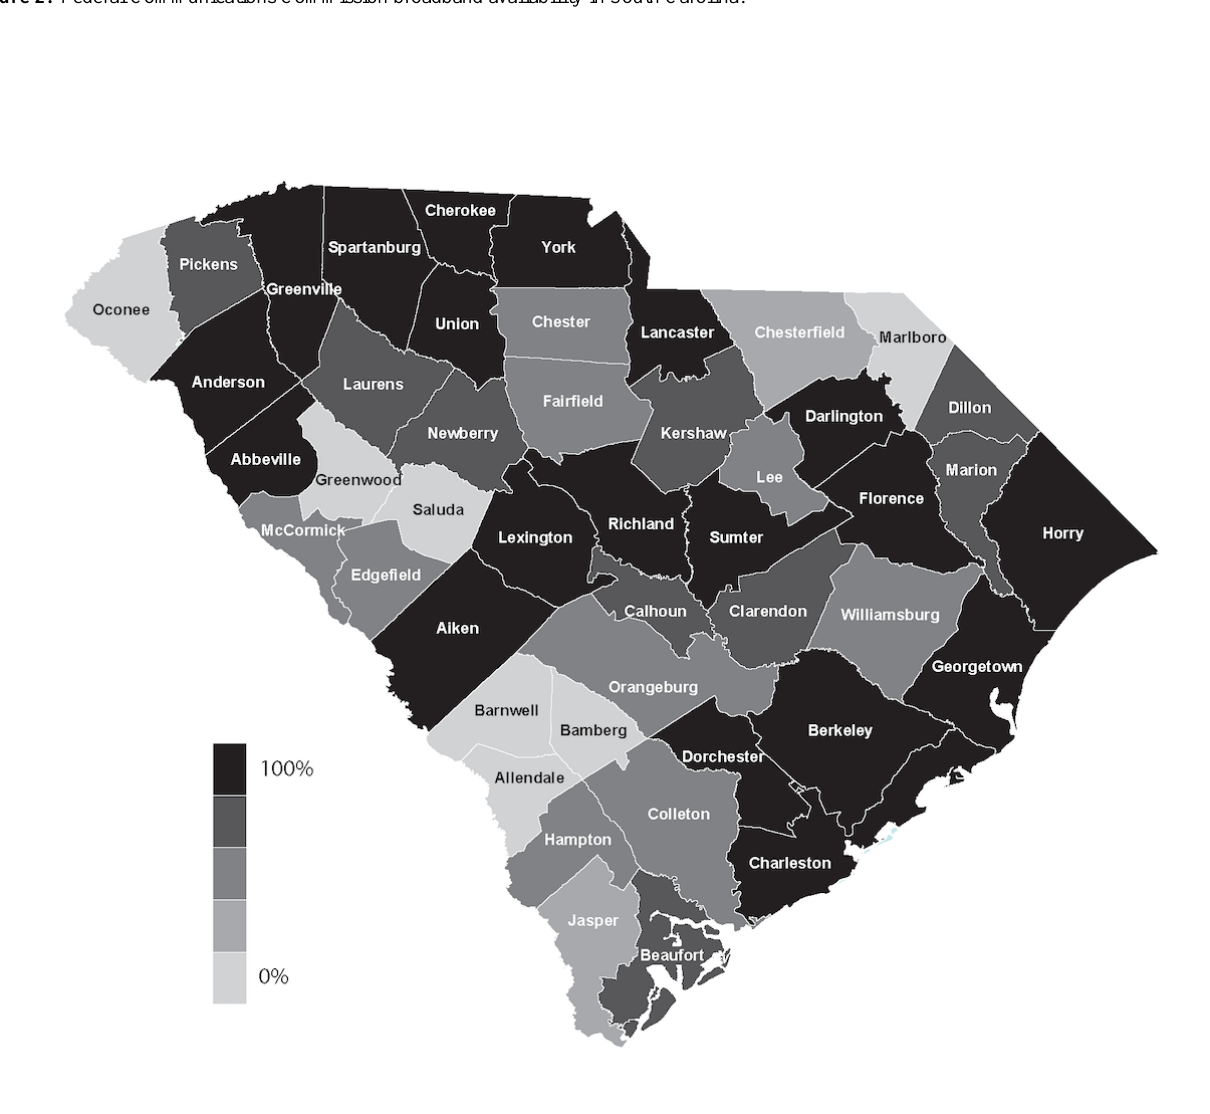
Figure 2. Federal Communications Commission broadband availability in South